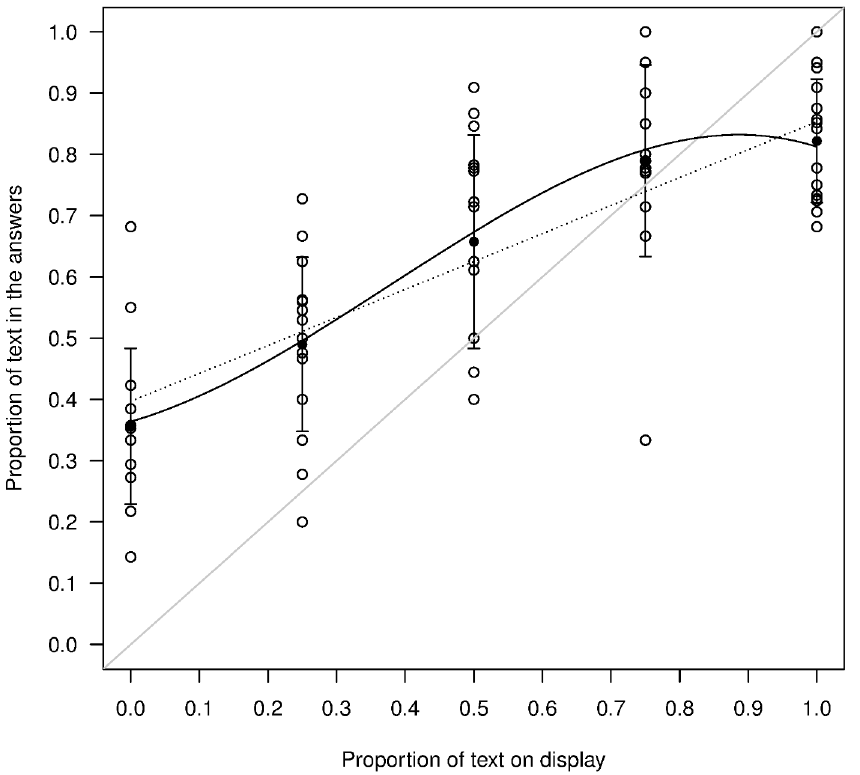
Figure 2. Conformist responses. Circles represent the proportion of text found in the answers for each of the 15 sessions in the 5 frequency conditions. Black disks represent the mean response and error bars are standard deviations. The plain black line represents the best fitting model described in Table 3, the dotted line the best linear fit and the plain grey line the y=x curve.